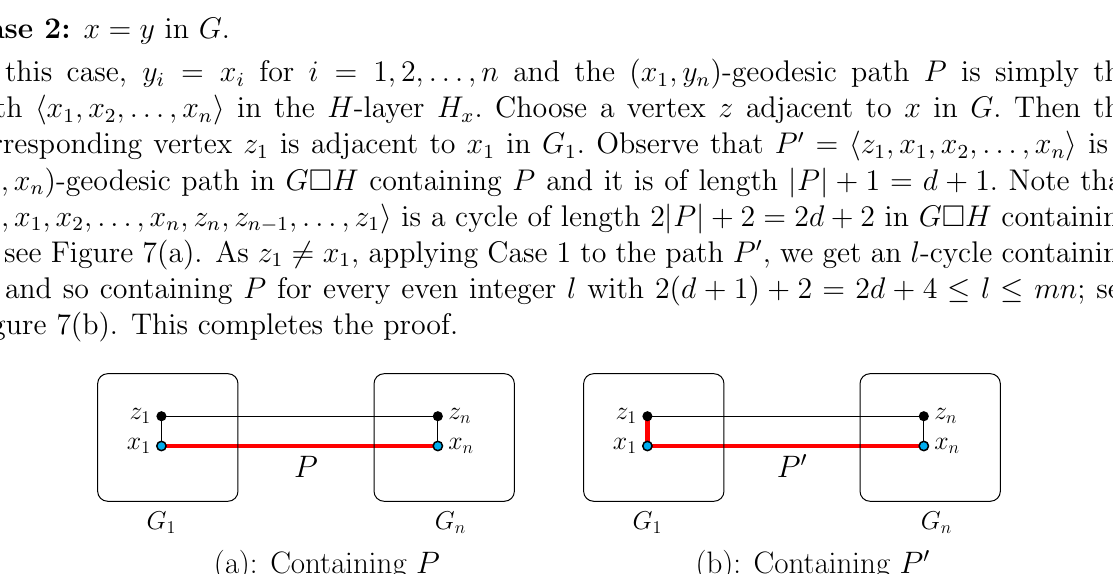
Figure 6: Cycles containing P when m ≥ 4 and n ≥ 4